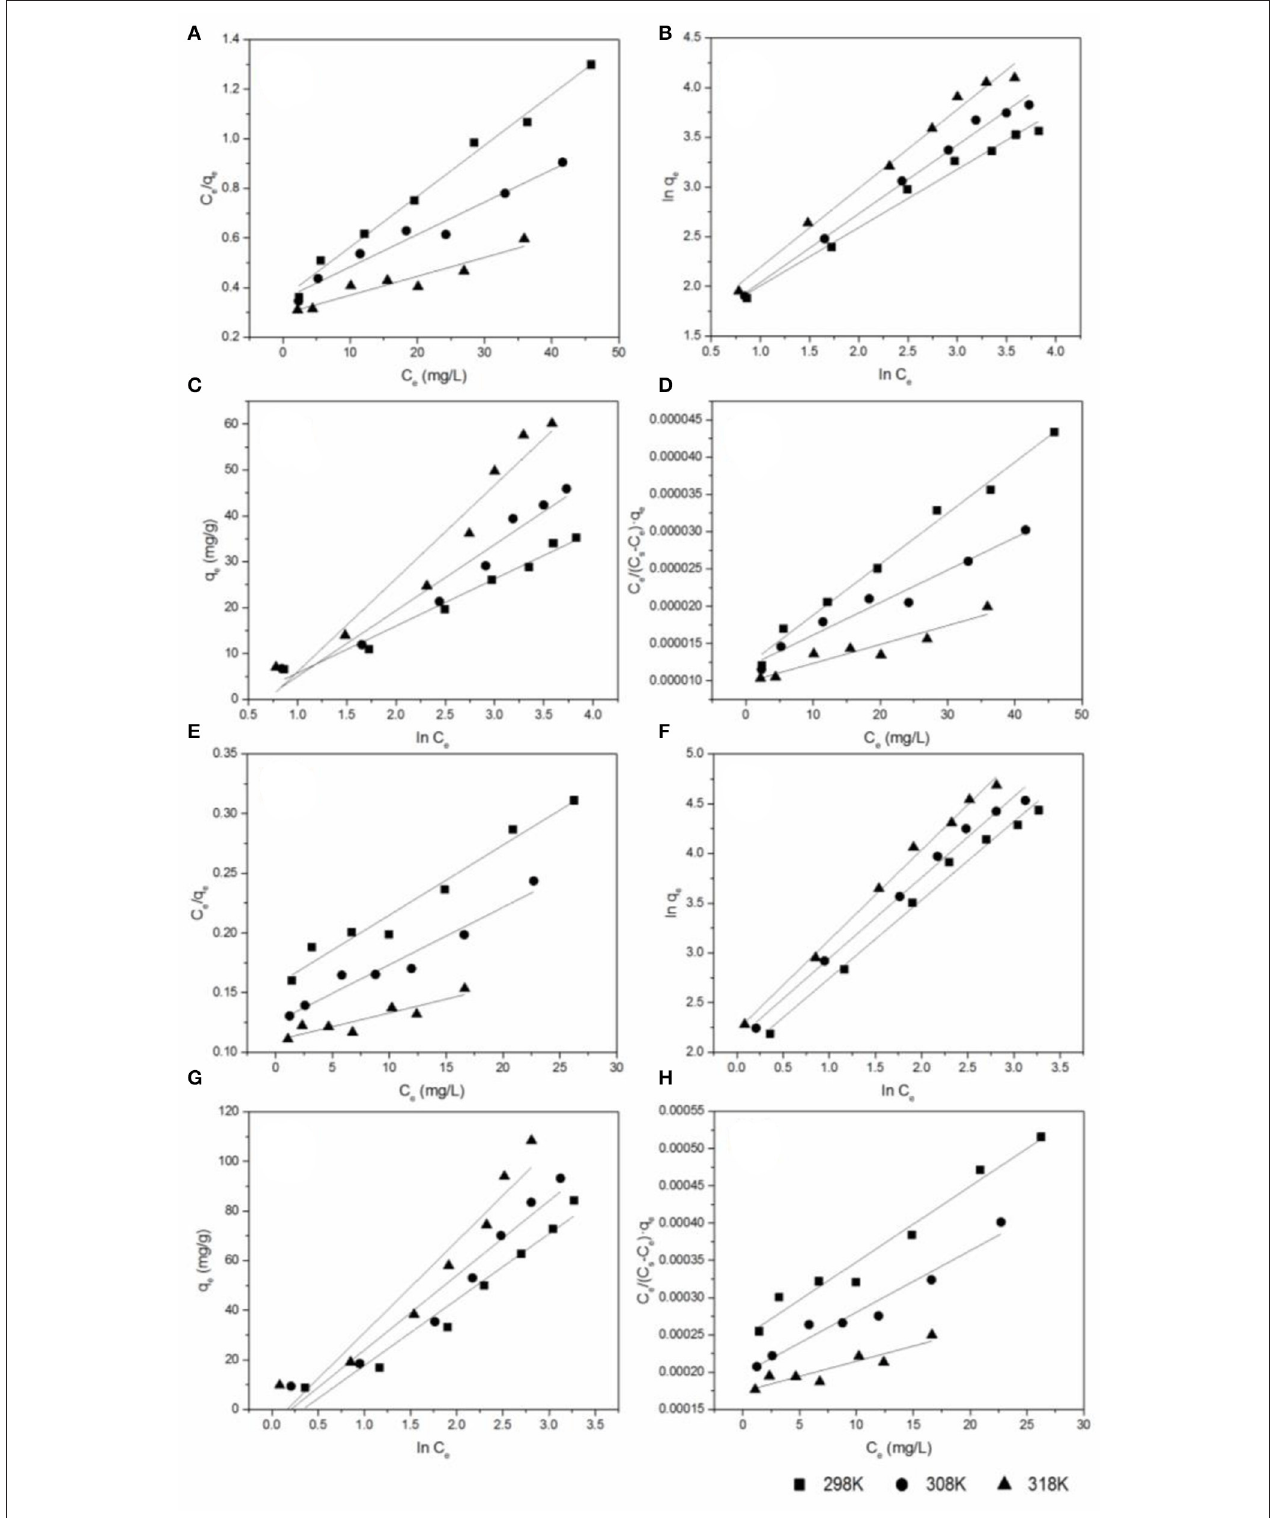
FIGURE 5 | The equilibrium isotherms for antibiotics adsorbed by BC700: (A) the Langmuir model of CIP; (B) the Freundlich model of CIP; (C) the Temkin model of CIP; (D) the BET model of CIP; (E) the Langmuir model of DOX; (F) the Freundlich model of DOX; (G) the Temkin model of DOX; (H) the BET model of DOX (sorbent dose = 0.4 g/L; pH = 6; contact time = 24h).